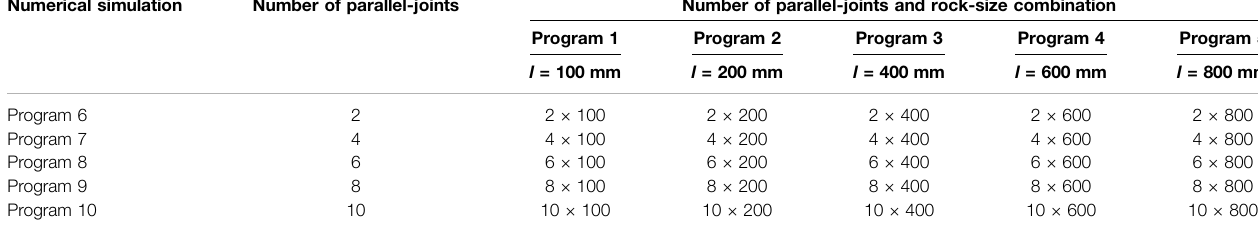
Frontiers in Earth Science |